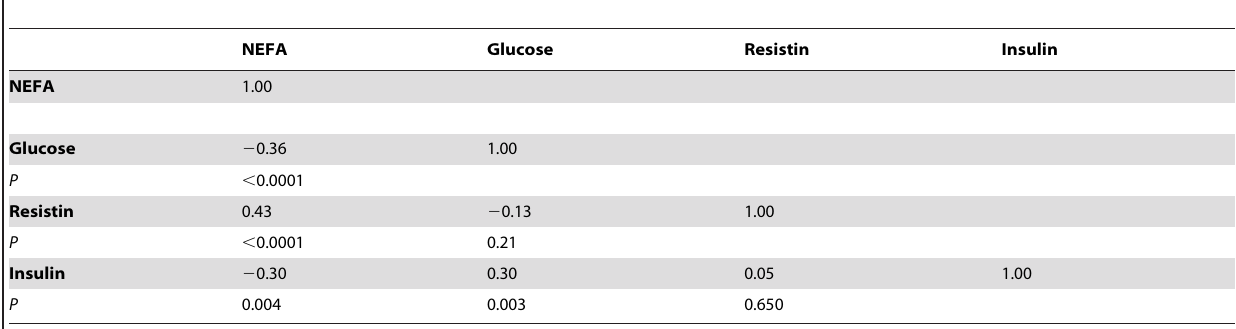
Table 3. Statistical analysis of the relationships between quantitative parameters (NEFA, glucose, insulin and resistin plasma levels during the period 4 weeks before calving to 22 weeks post partum) using Pearson correlations with the CORR procedure of the SAS